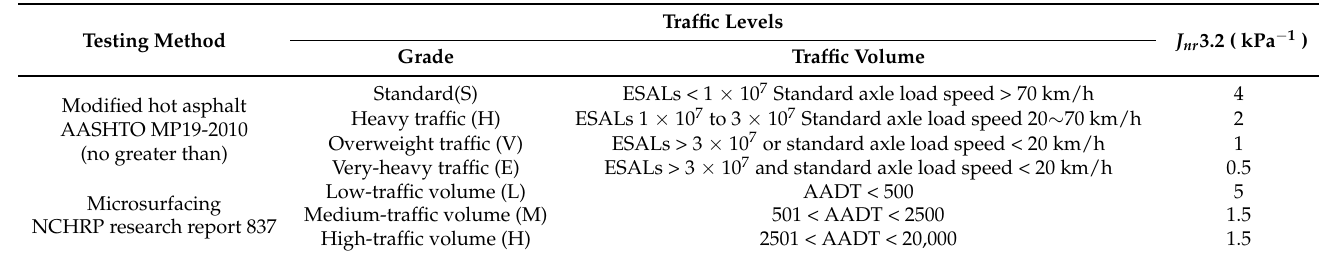
Table 6. Properties of asphalt emulsion.